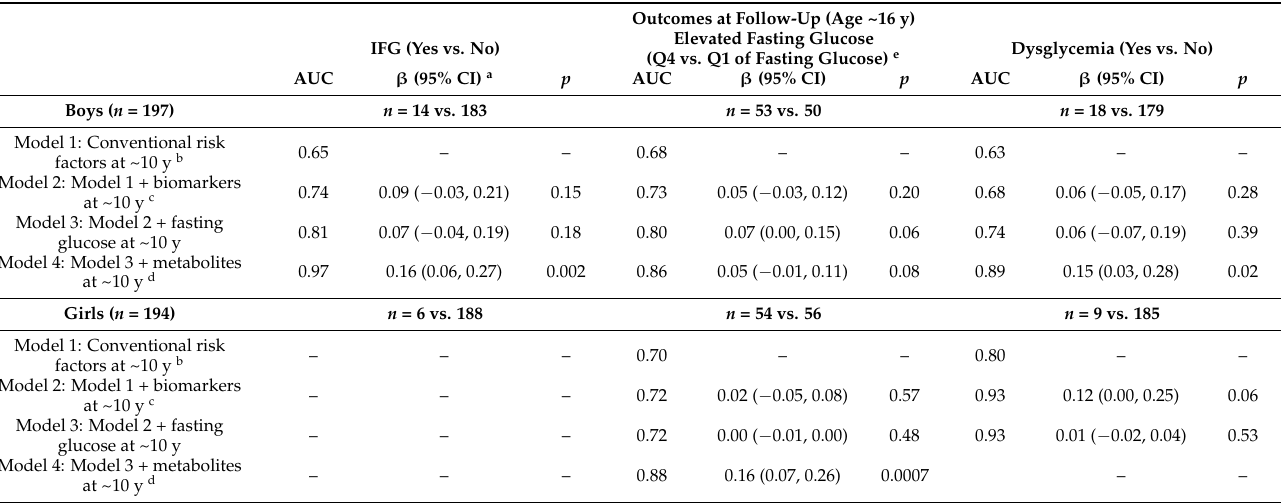
Table 3. Comparison of area under the receiver operating characteristic curve (AUC) for conventional risk factors vs. metabolites at baseline (age ~10 y) predicting impaired fasting glucose (IFG), elevated fasting glucose, and dysglycemia at follow-up (age ~16 y) in EPOCH. Outcomes at Follow-Up (Age ~16 y) IFG (Yes vs. No) Elevated Fasting Glucose (Q4 vs. Q1 of Fasting Glucose) e Dysglycemia (Yes vs. No) AUC β (95% CI) a p AUC β (95% CI) p AUC β (95% CI) p